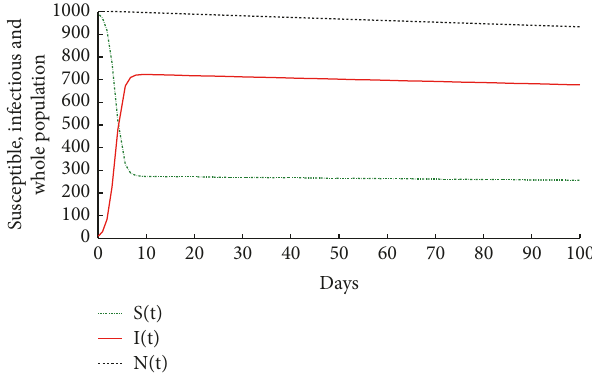
Figure 1: Proportions of susceptible and infectious subpopulations in the SISV model without vaccination when the basic reproduction numberofitscorrespondingnormalizedSISVmodelis 𝑅 0 = 3.6438 .